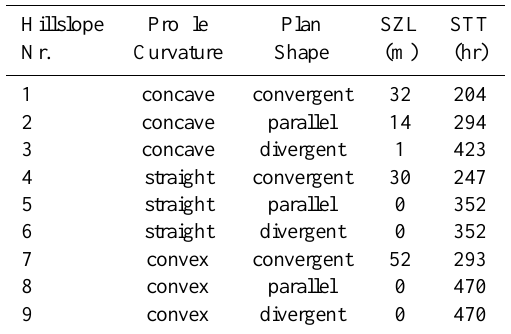
Table 3. SZL and STT in the nine basic hillslopes (N=30mm/day)